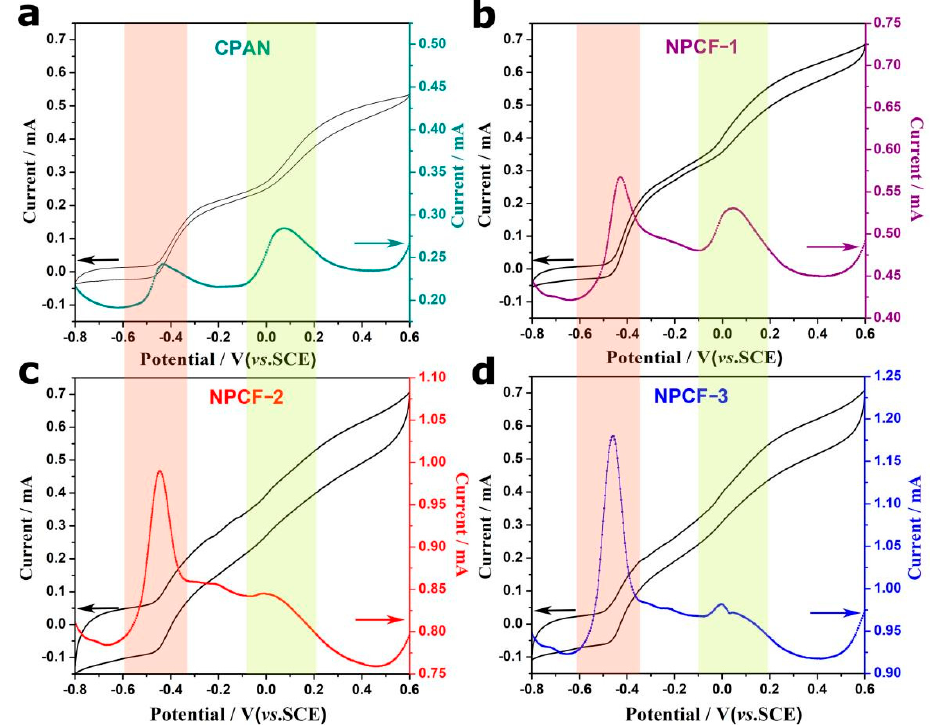
Figure 5. DPV and turnover CV curves of different porous carbon fiber anodes (( a ): CPAN, ( b ): NPCF-1, ( c ): NPCF-2, ( d ): NPCF-3) in S. putrefaciens CN32 half-cells.